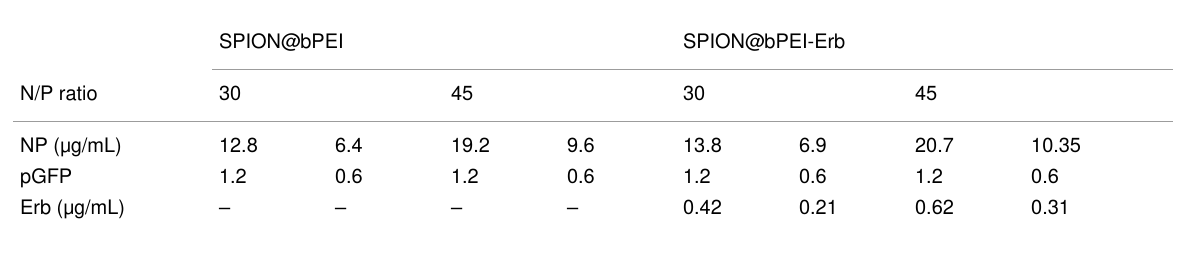
Table 1: Composition of the particles used for pGFP transfection.